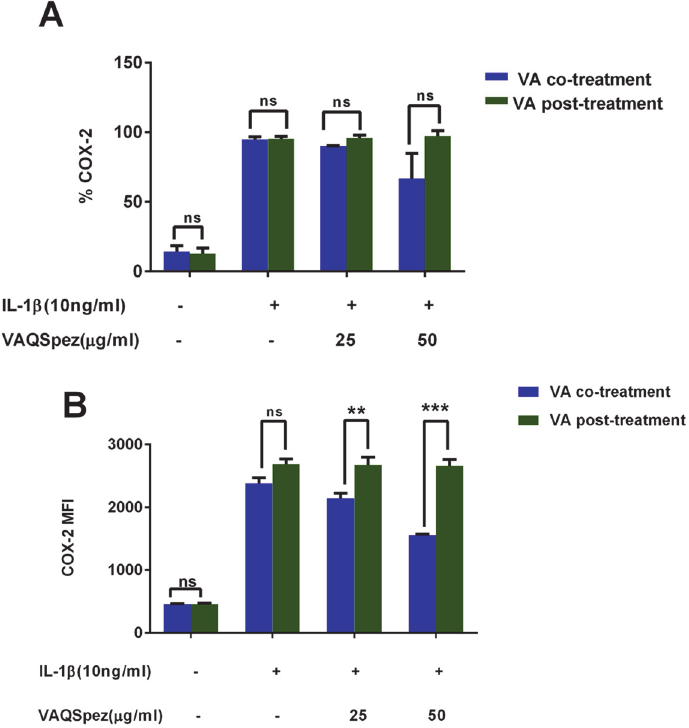
Fig 1. Co-treatment of A549 cell with IL-1 β and Viscum album inhibits the cytokine-induced COX-2 expression. A549 cells were treated with IL-1 β (10 ng/ml) and two different concentrations of Viscum album Q Spez preparation for 18 hours. Cytosolic COX-2 was measured using flow cytometric analysis. Viscum album is added to the cells either from the beginning of the experiment along with IL-1 β (co-treatment) or after 14 hours of IL-1 β induction (post-treatment). Percentage COX-2 expression as measured in intracellular staining by flow cytometry (A) and mean fluorescence intensity (MFI) of COX-2 expression (B) is shown. Results are mean ± SEM of 4 independent experiments ( ** p < 0.01; *** p <